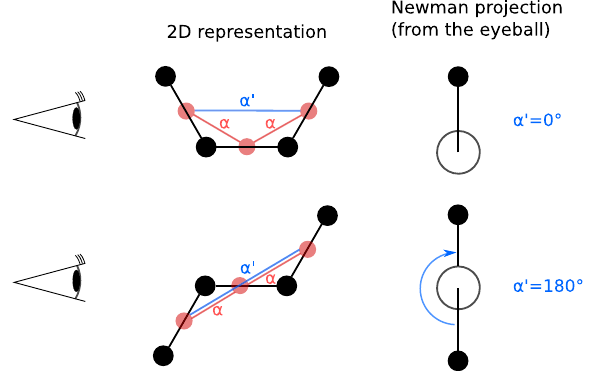
Fig. 1 The line graphs, shown as blue and red nodes and edges, encode angular information absent in the original atomic graph (black). Red edges capture bond angles α , and blue edges capture dihedral angles α 0 (de fi ned as the clockwise angle in the Newman projection between two bonds sharing a common bond). Distin- guishing these two con fi gurations requires inclusion of the dihedral angle in the graph encoding.